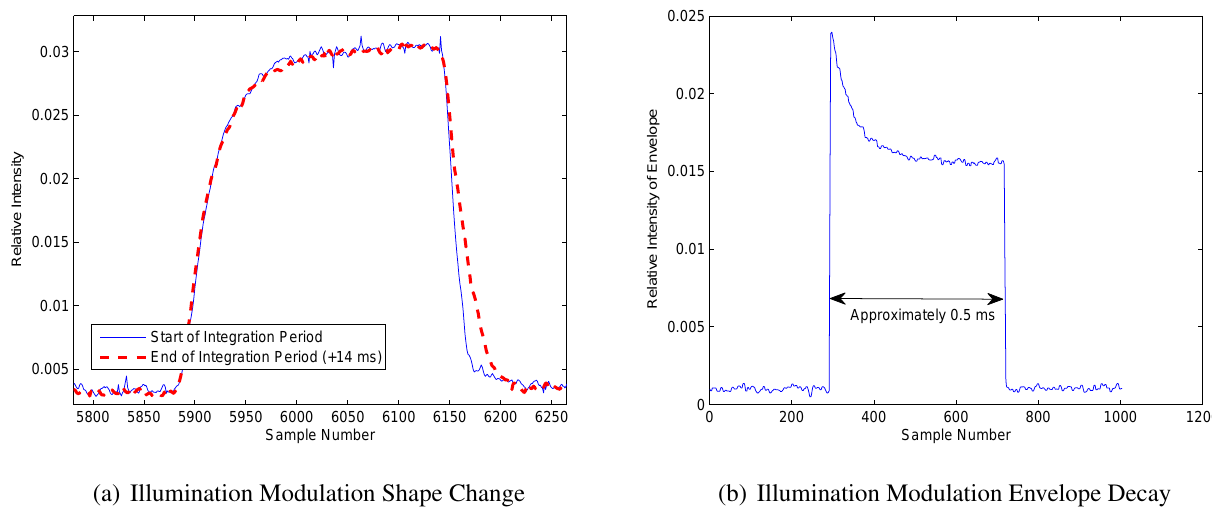
Figure 3. Variation in SwissRanger 4000 illumination modulation waveform shape within a single integration